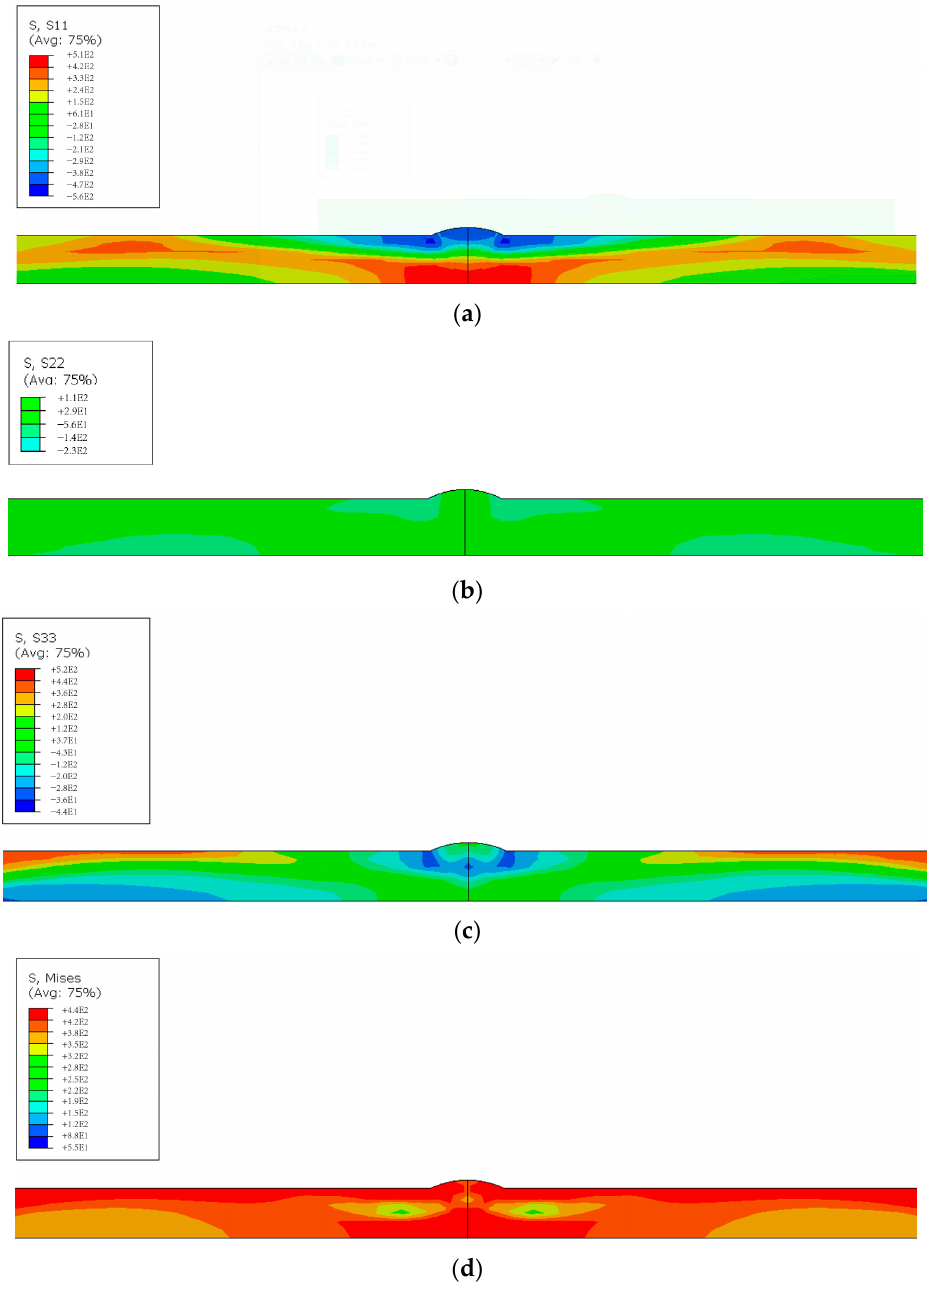
Figure 15. Stress components after liquid nitrogen exposure: ( a ) transverse stress σ x , ( b ) longitudinal stress σ y , ( c ) normal stress σ z , and ( d ) von Mises equivalent residual